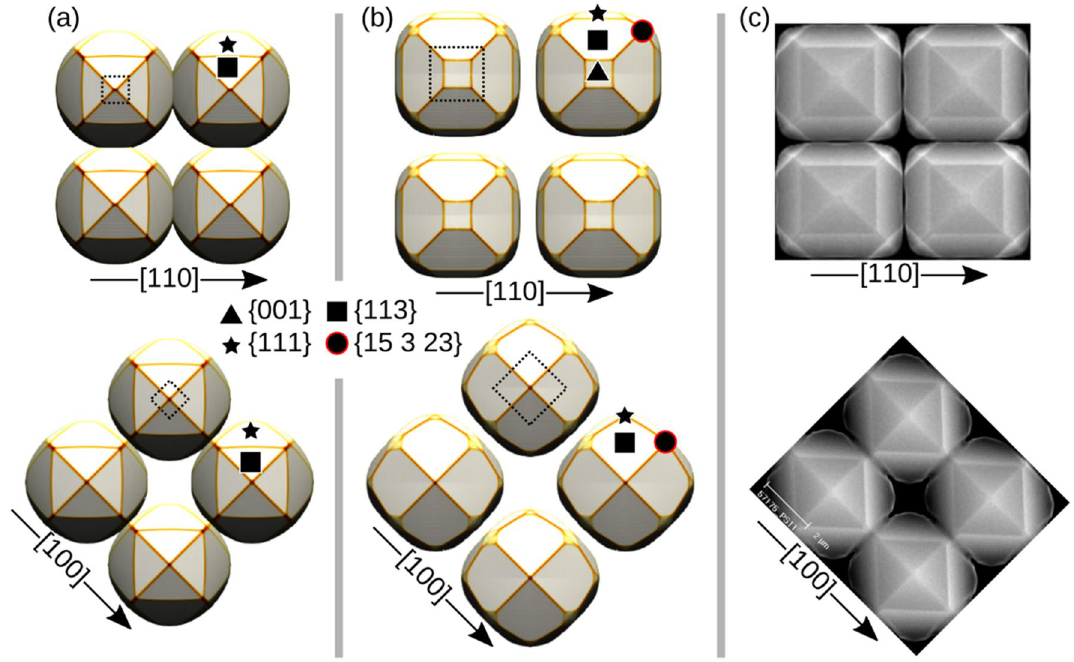
so that pillar rows are along [110] and [100] respectively. ( b ) The simulation for Ge on 2 × 2 μm Si pillars. The initial pillar is sketched by the dotted squares, a single pillar is simulated and then mirrored to mimic the